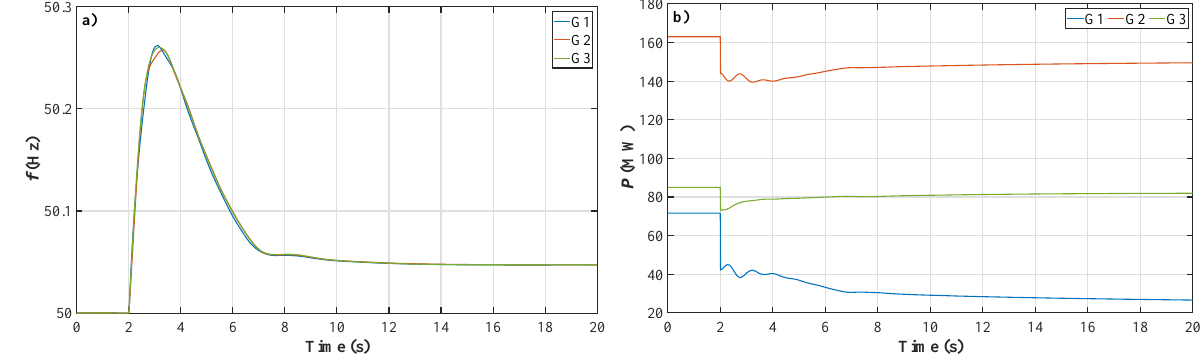
Figure 3. Examined event. ( a ) Frequency responses. ( b ) Active power